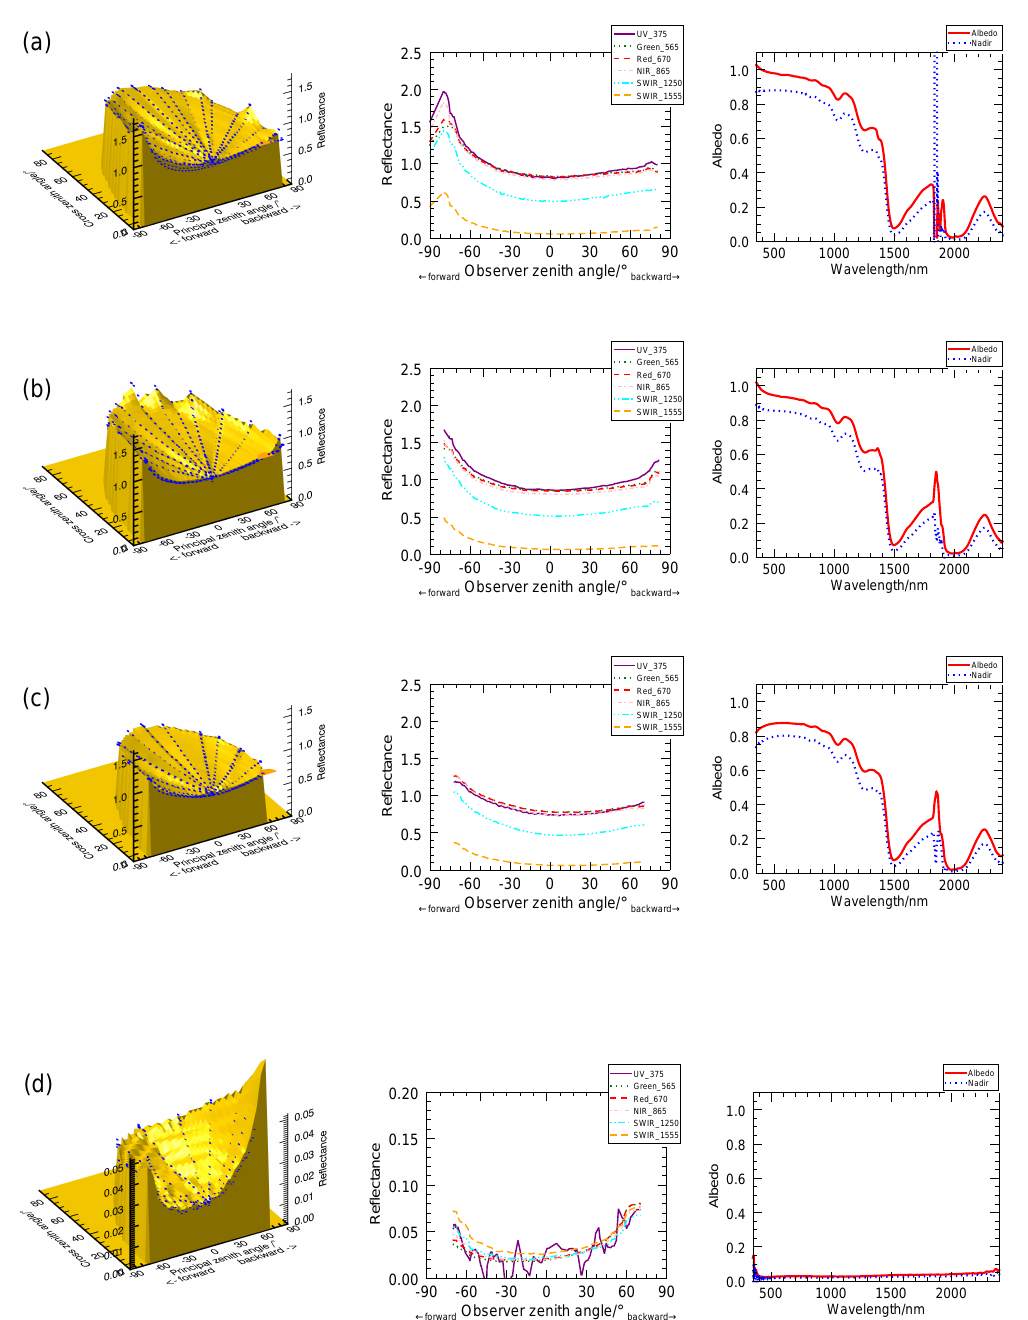
Figure 9. Left: BRF as a function of the observation direction integrated over the spectral range. Middle: The bidirectional reflectance factor (BRF) in the principal plane, at six wavelengths. Right: spectral albedo and BRF at nadir. (a) Natural snow 3 April 2013 11:33, solar zenith angle 63 ◦ , (b) snow covered with volcanic sand, 8g / 0 . 5m 2 , 3 April 2013, 12:25, 62 ◦ , (c) snow covered with volcanic sand, 8g / 0 . 5m 2 , 3 April 2013 13:23, 62 ◦ , (d) pure volcanic sand measured in